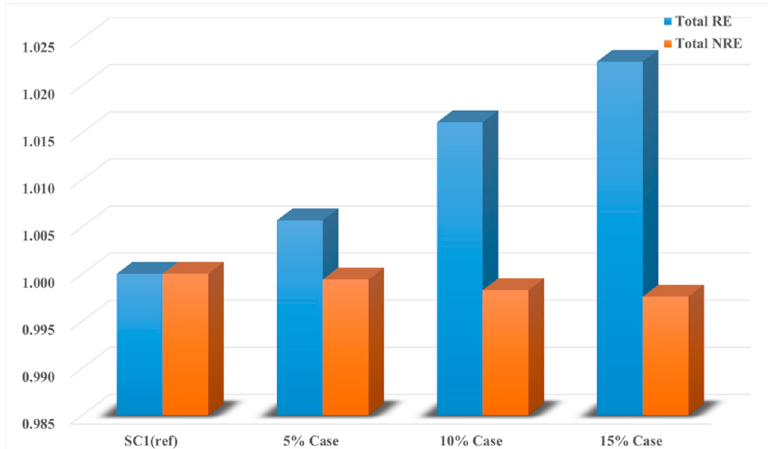
Figure 13. Power generation changes of RE/NRE considering CER price increases.